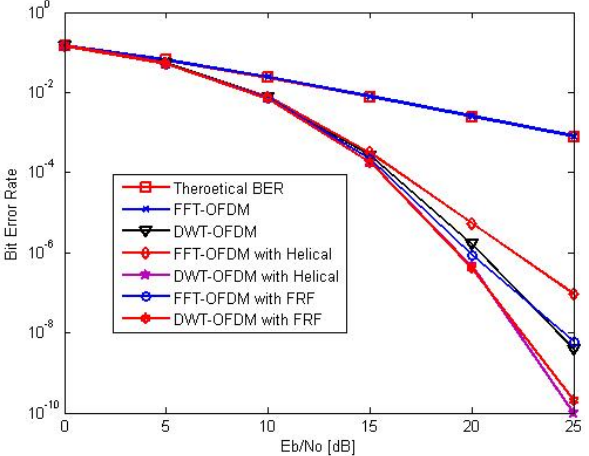
Figure 9. FFT − OFDM and DWT − OFDM BER performance over Rayleigh channel with exponential power delay profile channel without a Doppler effect.